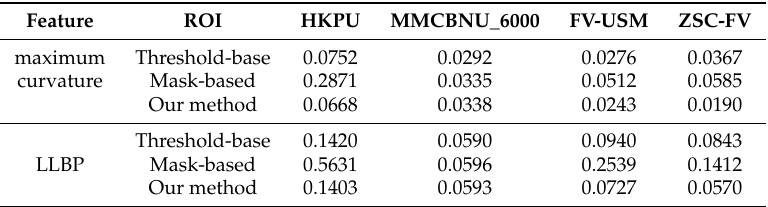
Table 4. EERscalculated on different kinds of ROIs by using maximum curvature [10] and local line binary pattern (LLBP) [13] features,